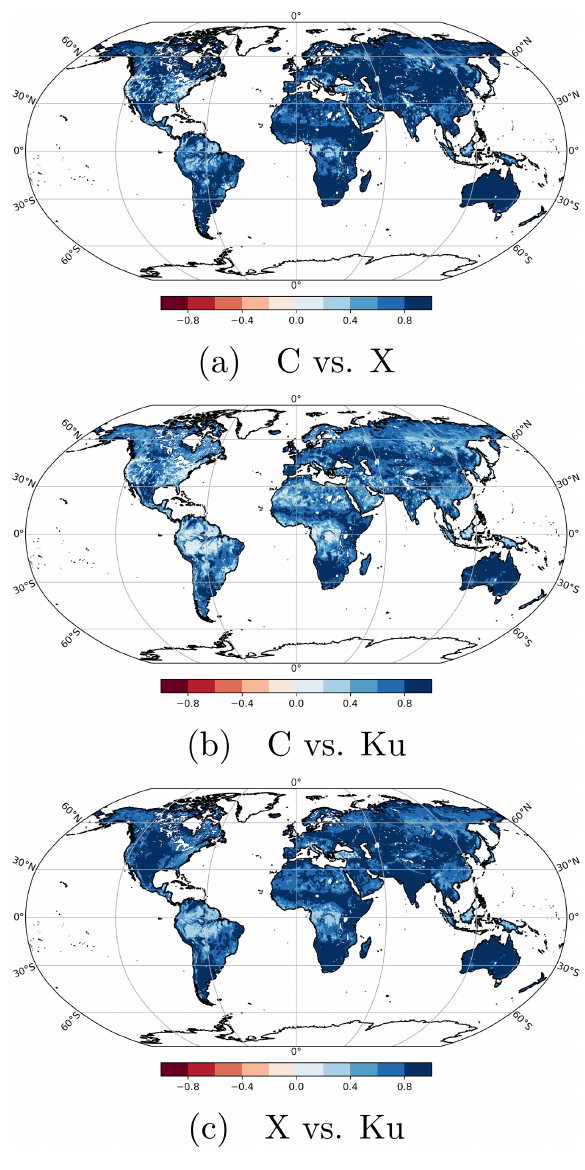
Figure 1. Exemplary correlation coefficients between C-, X- and Ku-band VOD anomalies of AMSR-E, derived with LPRM (Sect. 2.1.1). Similar results are obtained for other sensors (not